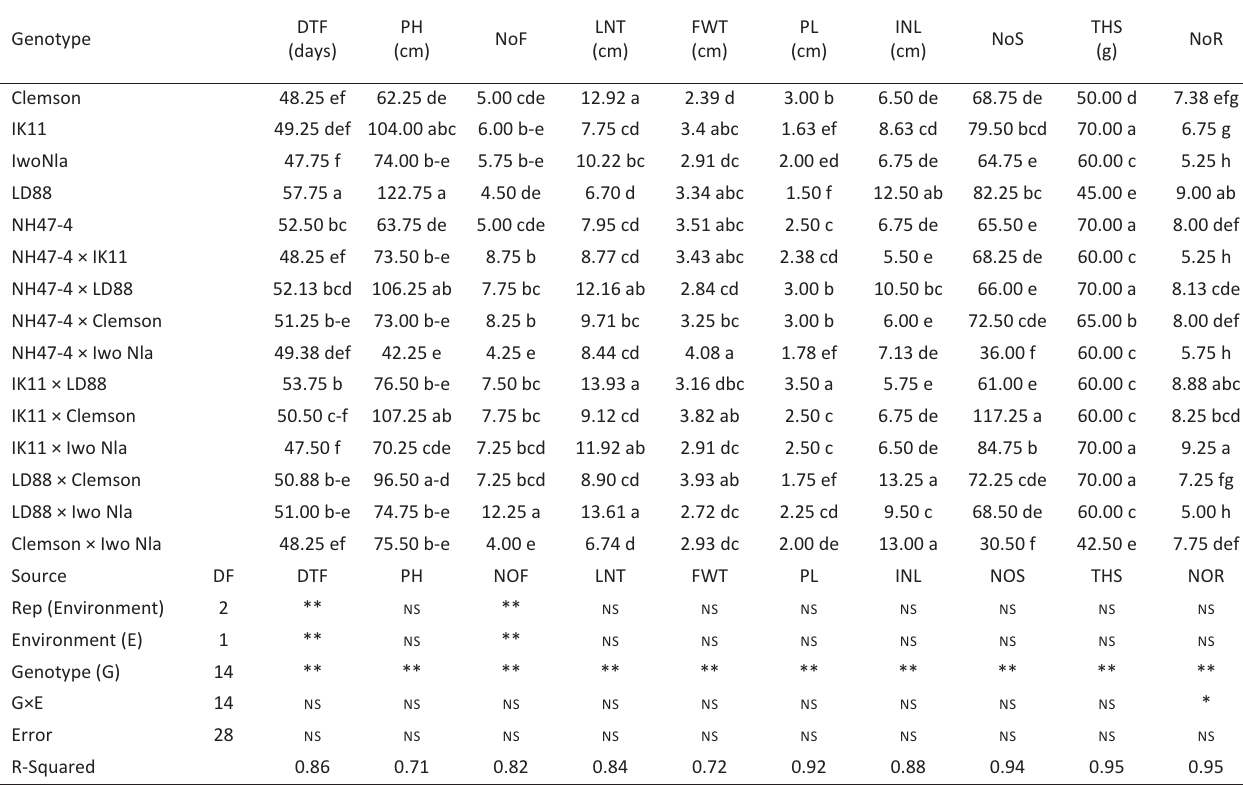
Table 1 ­ Analysis of variance of 15 genotypes of okra evaluated for selected traits across research